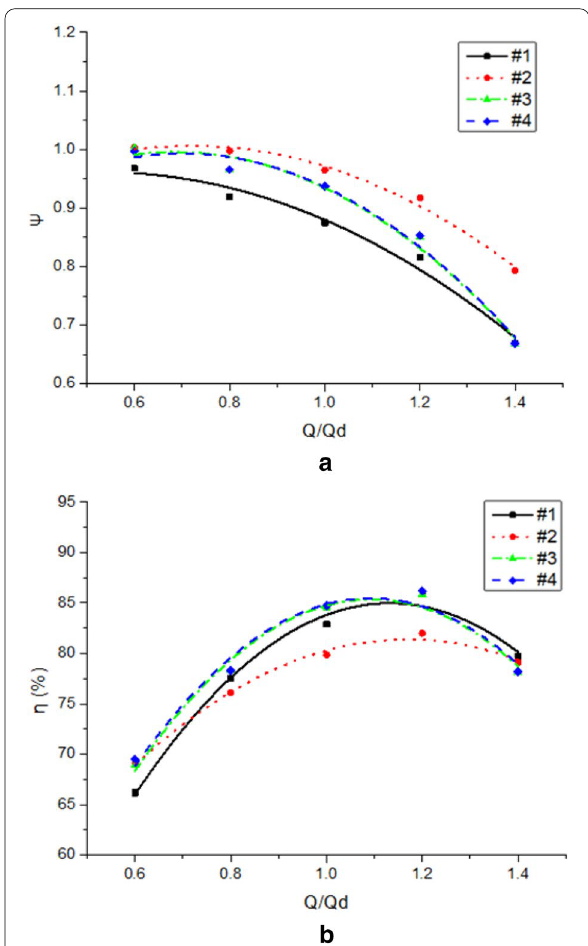
Figure 7 Performance curves of the simulated results for the four models: a Head coefficient curves; b Efficiency curves